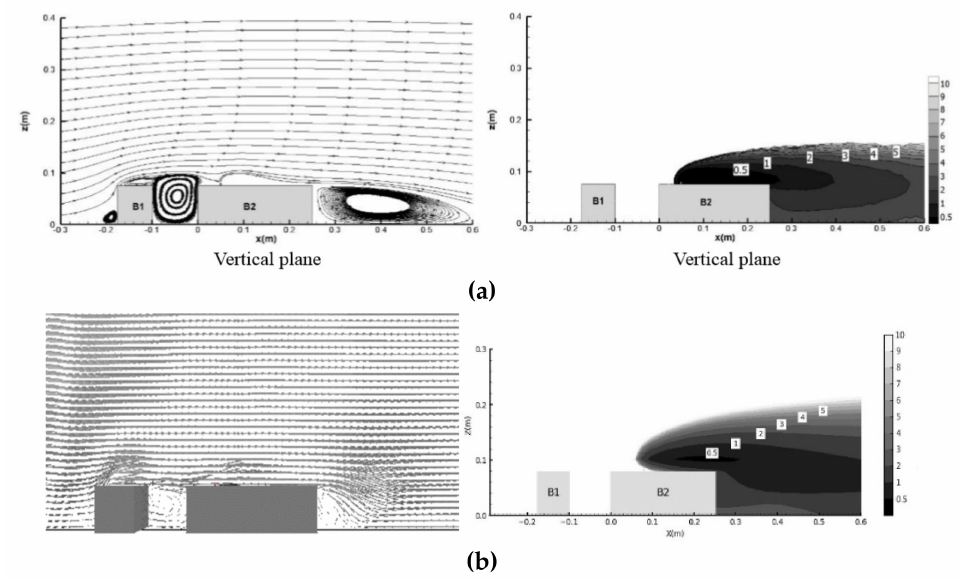
Figure 3. Qualitative comparison of the results between the reference paper and CFD simulation; ( a ) results of the reference paper; ( b ) results of